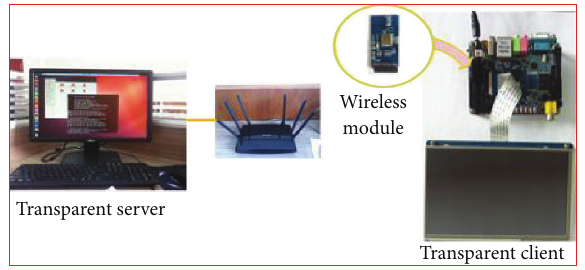
Figure 7: Experimental